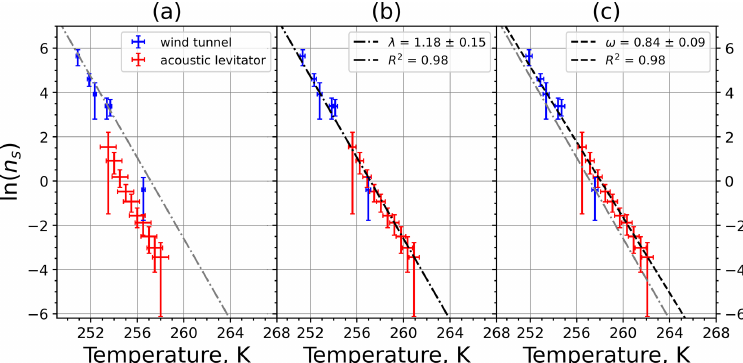
Figure A12. (a) Composite INAS density spectrum of Sahara dust from the uncorrected M-WT (blue) and M-AL (red) measurements. Panels (b) and (c) show the temperature-corrected data points from the M-WT and M-AL experiments based on λ and ω , respectively. The dash-dotted line in (c) is the regression line on corrected data points obtained by employing the optimal λ value as in (b)